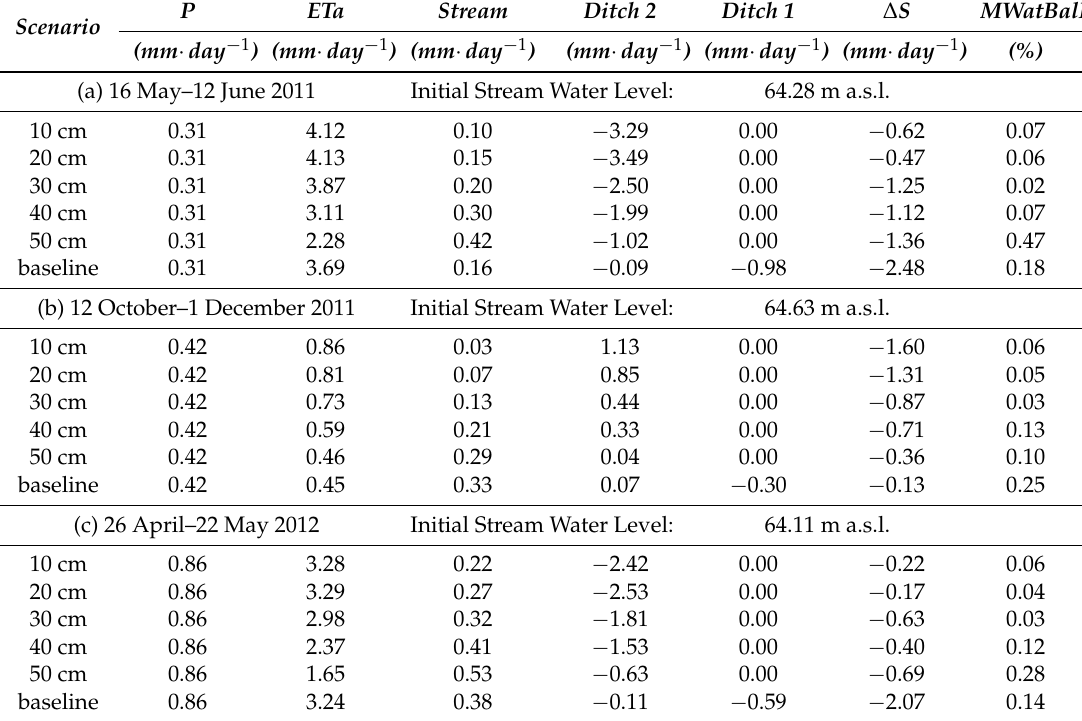
Table 4. Calculated mean fluxes at the model boundaries for the first 20 days of the periods ( a ) 16 May–12 June 2011; ( b ) 12 October–1 December 2011; and ( c ) 2 April–22 May 2012. Positive fluxes lead out of the model domain and vice versa . Precipitation ( P ), actual evapotranspiration ( ETa ), western lateral boundary ( Ditch 2 ), eastern lateral boundary ( stream ), and fluxes at Ditch 1 , as well as storage alteration ( ∆ S , differences in inflow and outflow of the model domain) and mean relative numerical error in the modeled water mass balance, are measured as quality criteria of the numerical solution ( MWatBalR ,